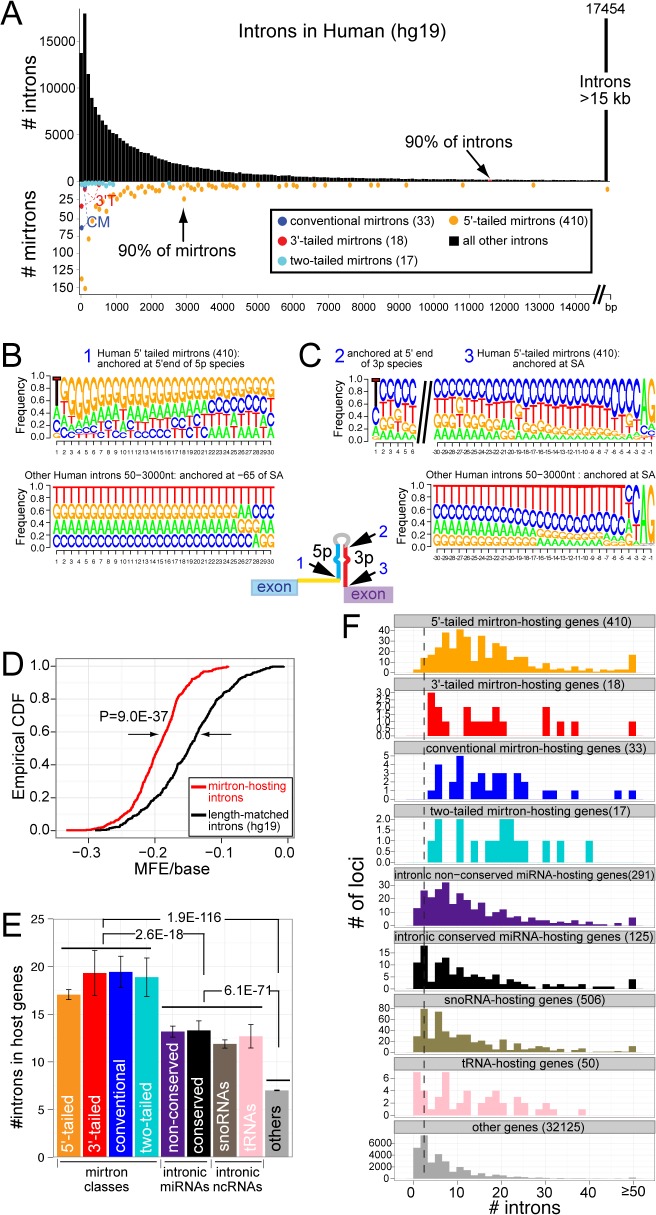
Sequence and length properties of mirtron-containing introns.(A) Comparison of mirtron-bearing introns with total introns in human. The distribution of total intron lengths is much broader than for mintrons. The dominant class of 5' tailed mirtrons derives mostly from introns that are <3kb in length, while the 3'-tailed mirtrons and conventional mirtrons derive from very short introns. (B, C) Nucleotide bias of small RNAs from 5'-tailed mirtrons. Three anchor points were considered, as schematized on the 5'-tailed mirtron model in the center (1, 2, 3, arrows). (B) Biased nucleotide identities of mirtron-5p reads from the dominant class of 5'-tailed mirtrons. Compared to an equivalent sequence range of control introns of similar length, mirtron-5p reads exhibit substantial 5'-U bias and overall enrichment of G across their lengths. The G bias is greater in the 5' than 3' regions of the mirtron-5p reads, and is not evident in bulk intron sequences downstream of their ~22 nt lengths. (C) Biased nucleotide identities of mirtron-3p reads from the dominant class of 5'-tailed mirtrons. Compared to control introns, there is substantial 5'-U bias (evident with aligning by their 5' ends) and substantial C-bias across their length. Note that the bulk introns exhibit polypyrimidine tracts upstream of the splice acceptor site (YAG), but mirtrons exhibit greater representation of C while control introns show greater bias for U. (D) Mirtronic regions exhibit much lower minimum free energy (MFE) than control intronic regions. CDF (cumulative distribution function) is plotted for MFE/base distribution. (E) All four classes of mirtrons are hosted by genes with greater numbers of introns than average genes. Various classes of other intronic non-coding RNAs (e.g. tRNAs, snoRNAs, and either conserved or non-conserved canonical miRNAs) typically reside in genes with larger numbers of introns than bulk genes, but their averages are intermediate to all classes of mirtrons. (F) Bar graphs that emphasize the individual properties of genes that host various classes of non-coding RNAs. It is evident that the all four classes of mirtrons have a broader distribution of intron numbers relative to other types of non-coding RNAs.